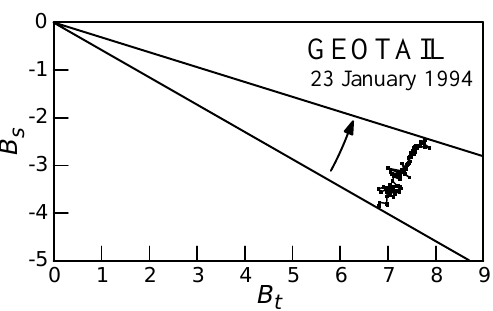
Fig. 7. Through the rotational layer of the double discontinuity shown in Fig. 6, the magnetic field rotates by an angle of ∼ 13 ◦ about the normal direction of the shock surface, while its magni- tude remains nearly constant.